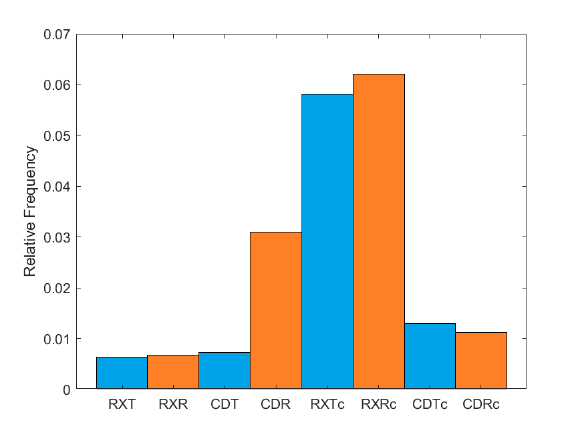
Figure 5. Area 1: Relative frequencies of anomalies. RXT: RX-Detector applied on the determined temperatures. RXR: RX-Detector applied on the LWIR image. CDT: change detection between the determined and simulated temperatures. CDR: change detection between the given and simulated LWIR image. RXTc, RXRc, CDTc, CDRc: as before, but with each class considered separately and finally